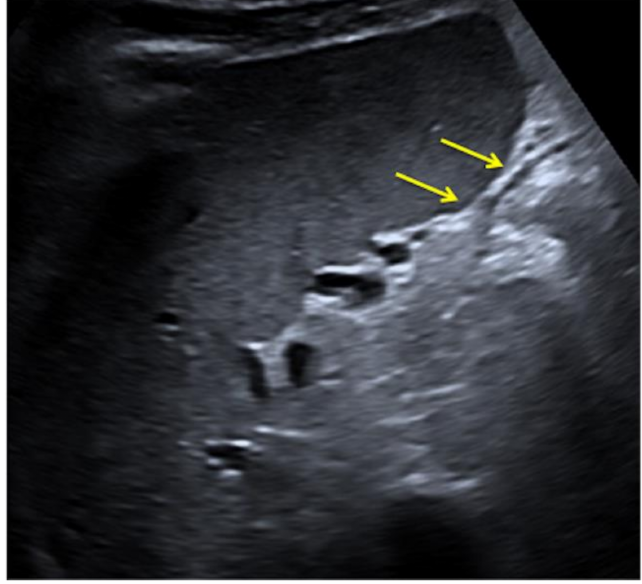
Figure 12. Pseudo-fluid produced by adaptive image processing artifact